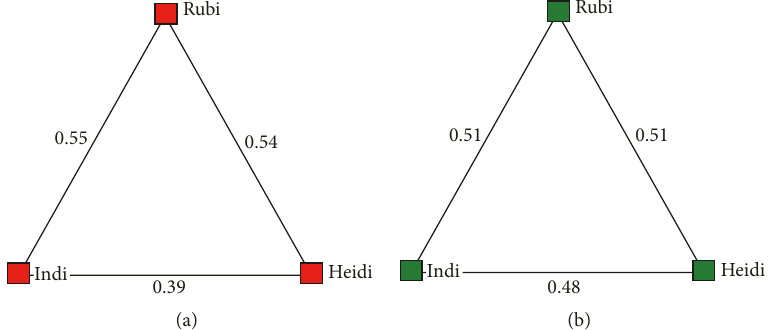
Figure 8: Sociograms displaying the Association Index values for the relationship between the lions at Whipsnade Zoo (a) and London Zoo